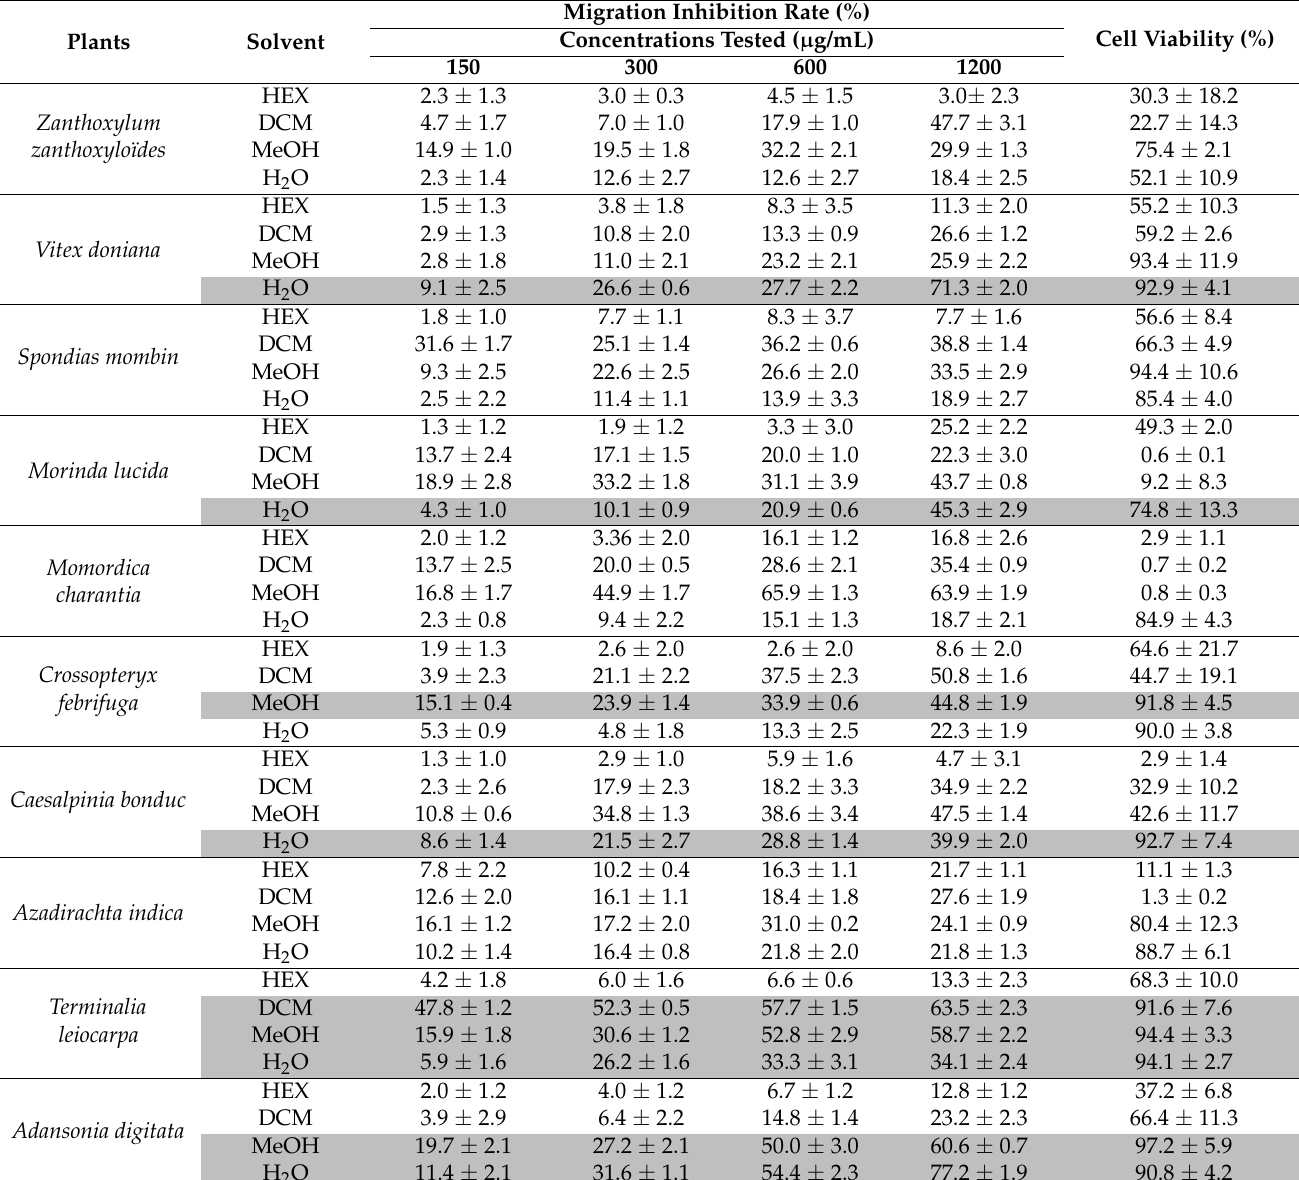
Table 4. Migration inhibition rate (in %) of infective Haemonchus contortus larvae (L3) and viability (in %) of WI38 cells (treated at a concentration of 100 µ g/mL) according to the extracts of the plants